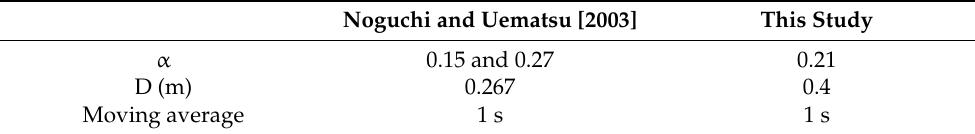
Table 6. Comparison of the experimental conditions